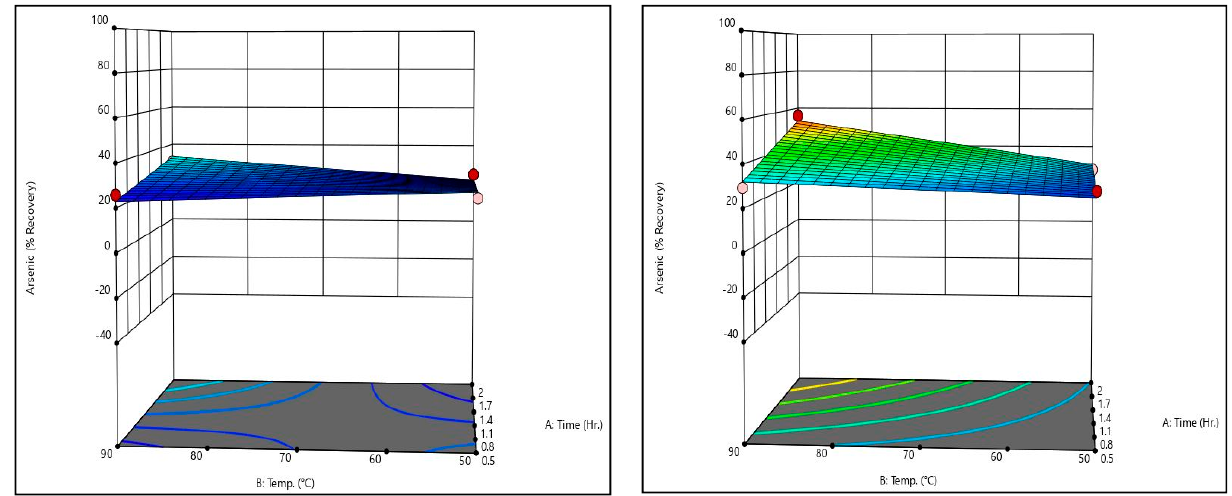
Figure 12. Sulfurous acid arsenic recovery response surfaces: low acid ( left ) and high acid ( right ).